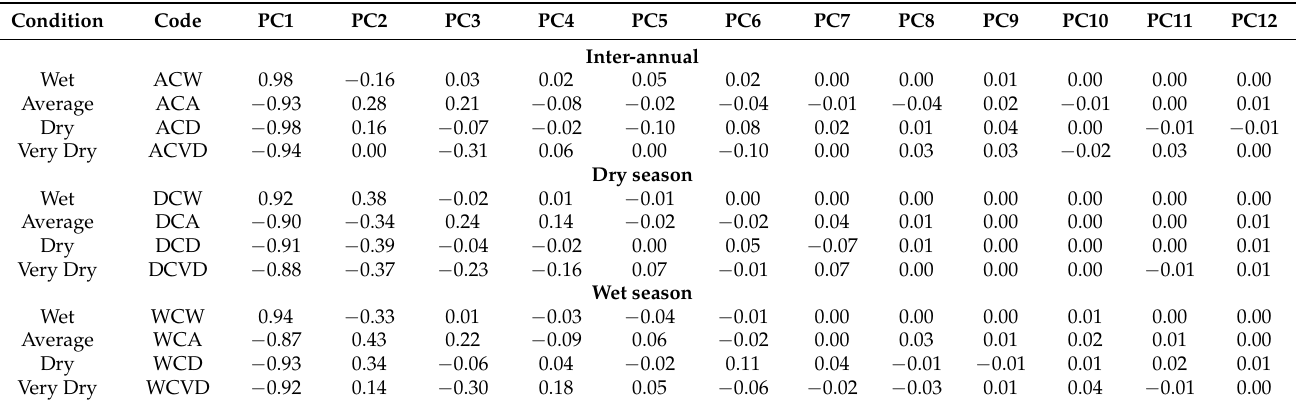
Figure A1. Percentage of variance (%) for the complete set of principal components. Principal components 1 and 2 gathered 98% of the cumulative variance (88% and 10%, respectively). The selection of such components was made based on the broken stick method (95% confidence interval). Table A1. Matrix of correlations for the complete set of principal components.